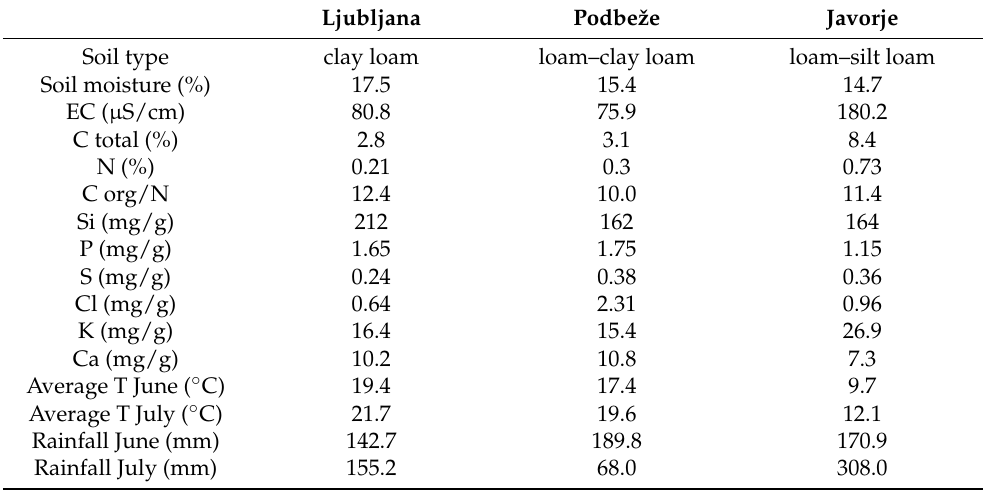
Table 1. Properties of soil and weather conditions of experimental locations Ljubljana, Podbeže and